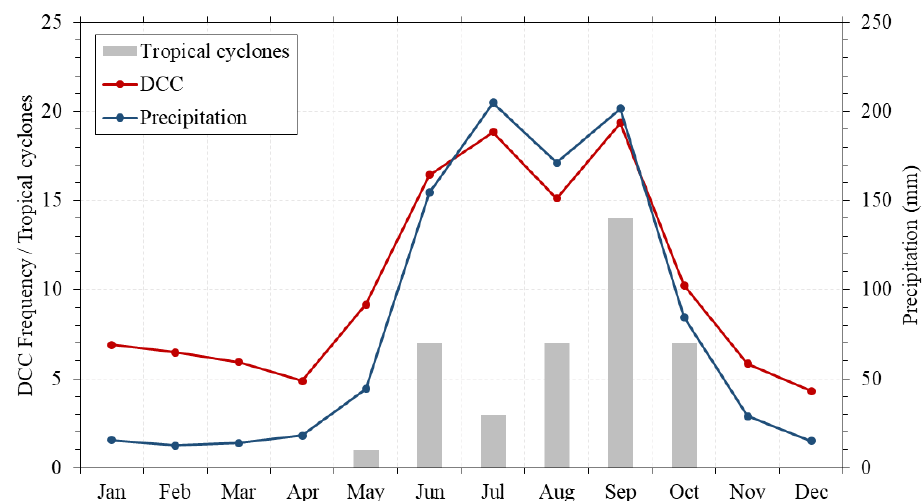
Figure 6. Monthly domain-average of deep convective cloud frequency, accumulated precipitation and tropical cyclone activity. The red line represents the domain-averaged total number of observed DCC based on MODIS data with a horizontal resolution of 0.1 degrees; the blue line represents the domain-averaged monthly mean precipitation amounts based on CHIRPS data with a spatial resolution of 0.05 degrees, and the grey bars represent the number of tropical cyclones that affected the study region. All parameters are shown for the period